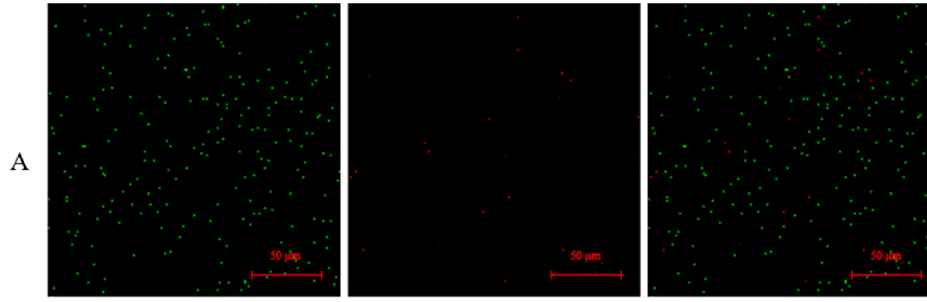
Figure 7. Laser confocal microscopy combined with dye to discriminate between live and dead bacteria. ( A – E ) denoted yogurt with different combinations of LC + LD + ST, LF + LD + ST, LB + LD + ST, LA + LD + ST, and LD + ST, respectively. The green fluorescence on the left indicated the live bacteria in the yogurt, whereas the red fluorescence in the middle indicated the dead bacteria in the yogurt, and the combination of the two is shown on the right.